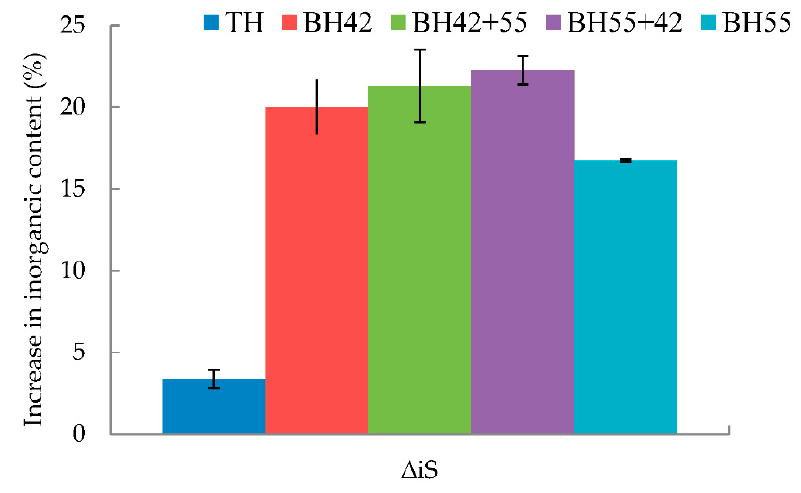
Figure 2. Change in inorganic matter content caused by TH and BH treatments.